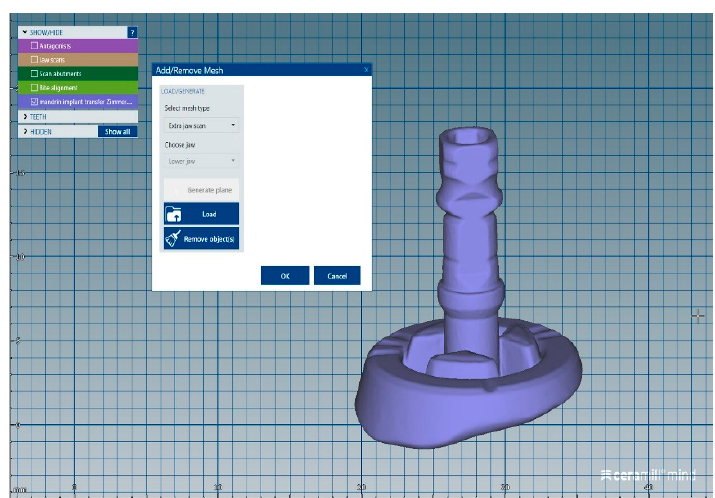
Figure 3. STL file of the analog transfer together with an area from the chuck. 7. Mount the digital scan body in the transfer accessory. 8. Scan with an intraoral scanner the scan body together with a sufficient area of the chuck in order to permit correct indexing in the CAD software; export as an STL file (Figure 4).